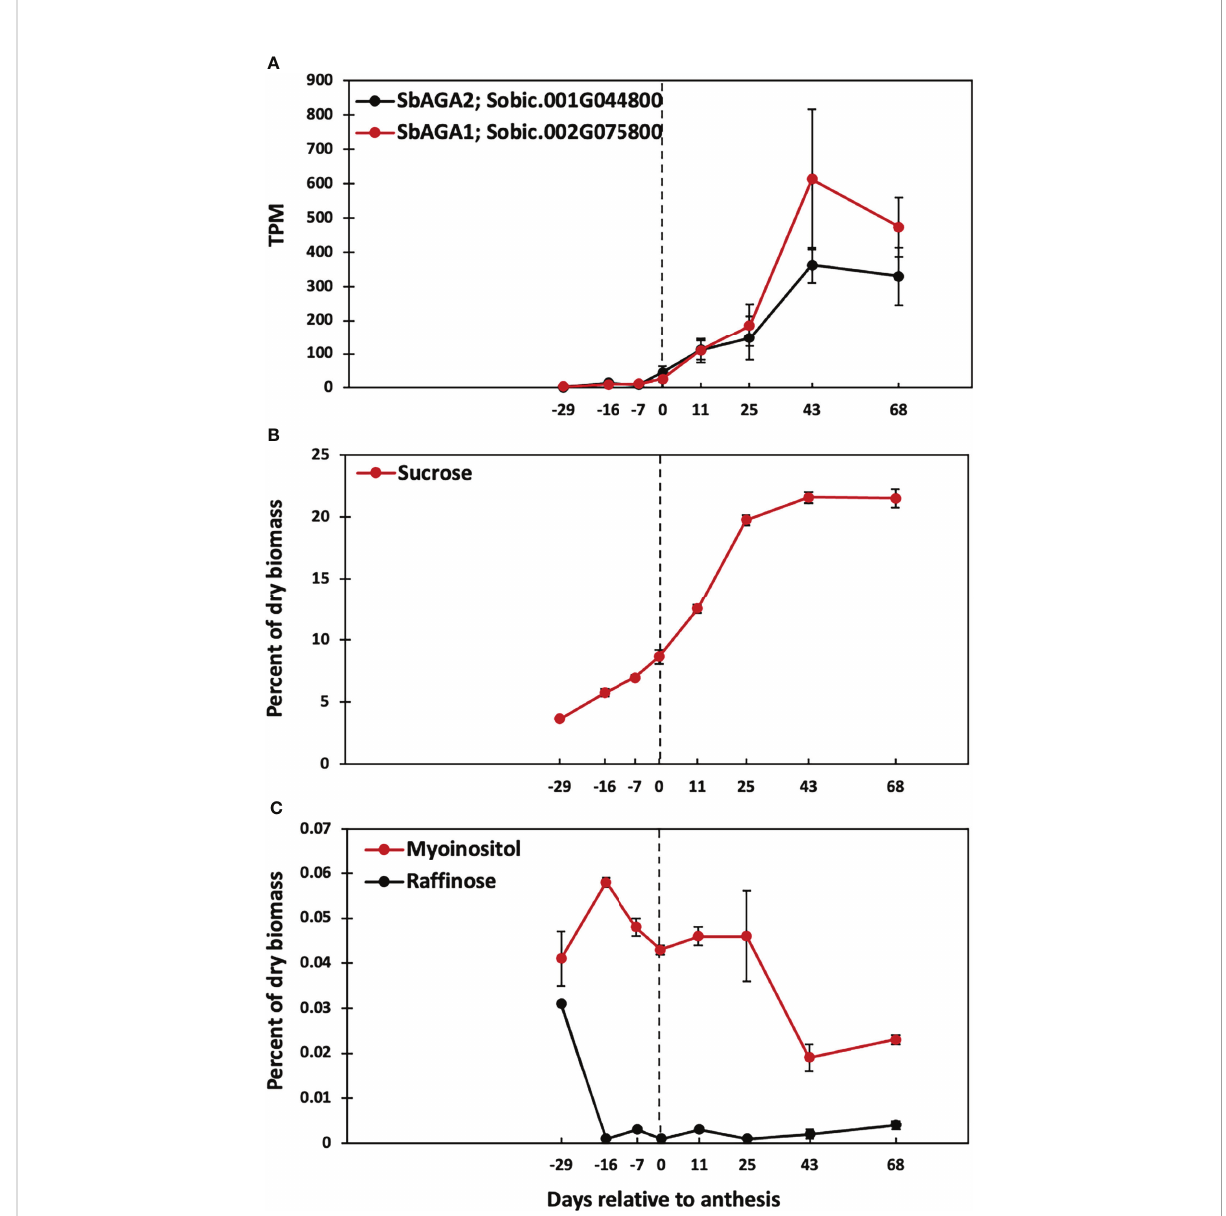
FIGURE 10 Time course of SbAGA expression and sugar accumulation in stems of Della grown in the greenhouse in 2011. Anthesis occurred at 91 DAE and is represented by the dotted line. (A) SbAGA1 and SbAGA1 TPM normalized expression in Della stems from 62 DAE to 159 DAE. n = 3. Error bars represent S.E.M. (B) Internode sucrose content of Della stems from 62 DAE to 159 DAE. n = 3. (C) Internode myo-inositol and raf fi nose content of Della stems from 62 DAE to 159 DAE. n =